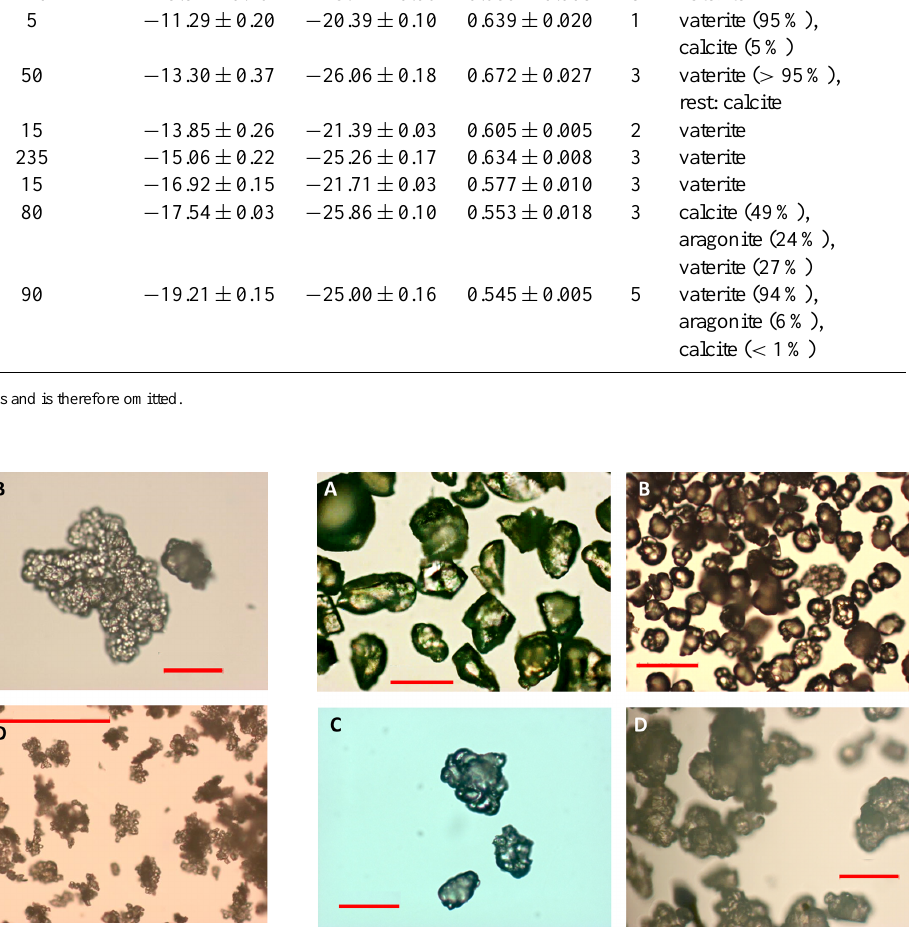
Figure 3. Photomicrographs of CaCO 3 minerals precipitated in the laboratory experiments. Scale bar is 100µm. Vaterite crystals formed at 23 ◦ C (a) , at 37 ◦ C in experiment NA-3 (b) and NA-4 (c) , and at 50 ◦ C in NA-5 (d)